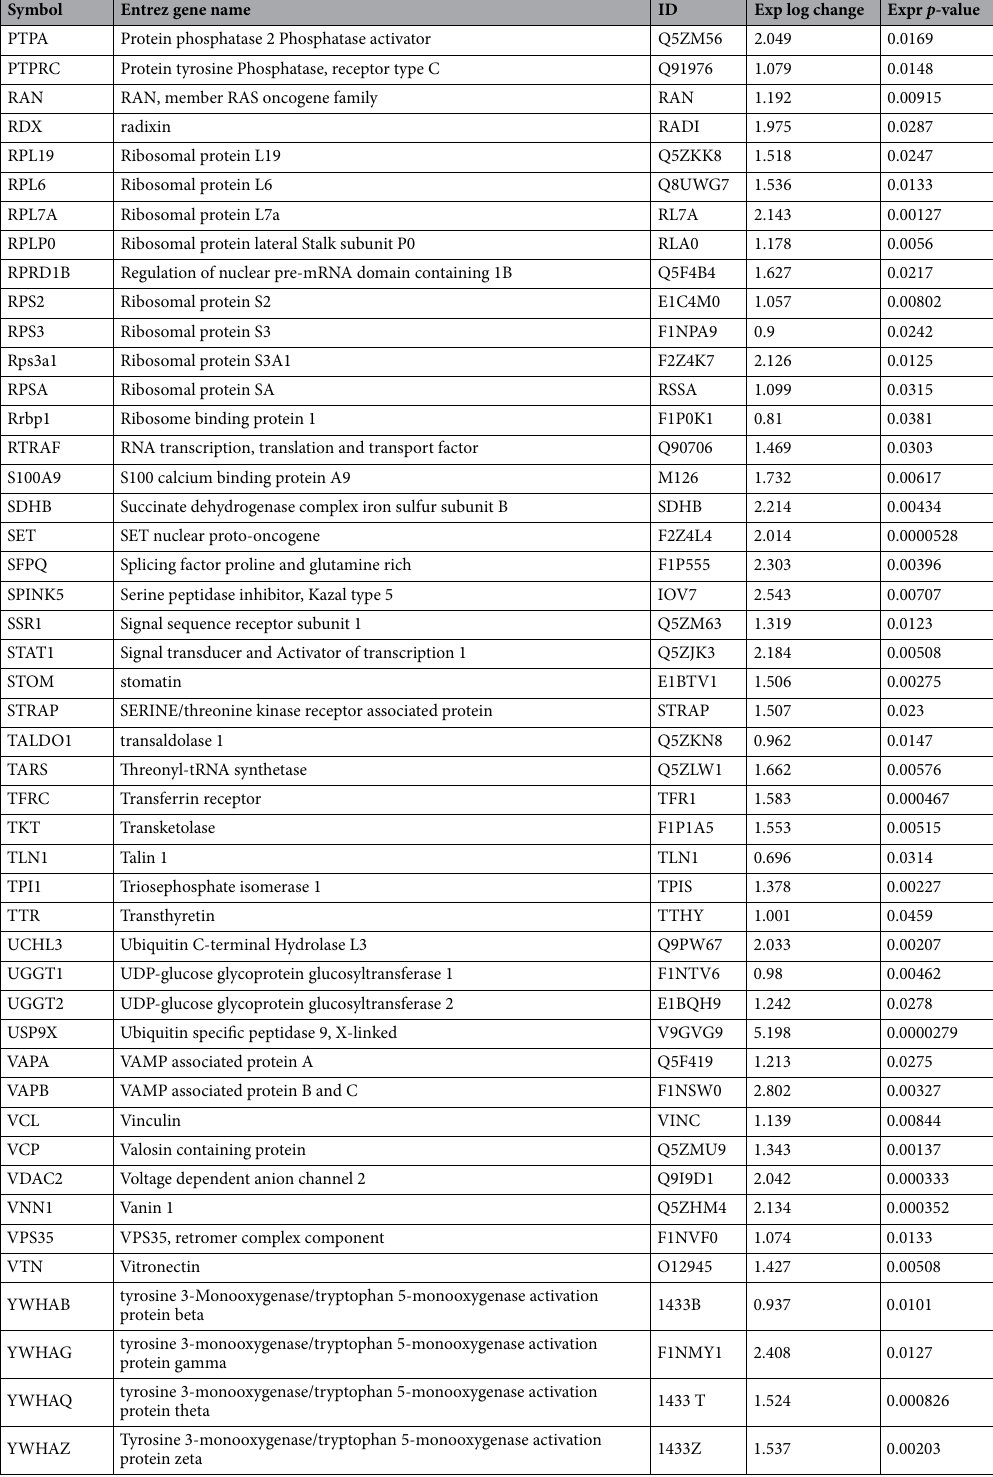
Table 2. Differentially expressed (up regulated) proteins in tibia of BCO compared to healthy